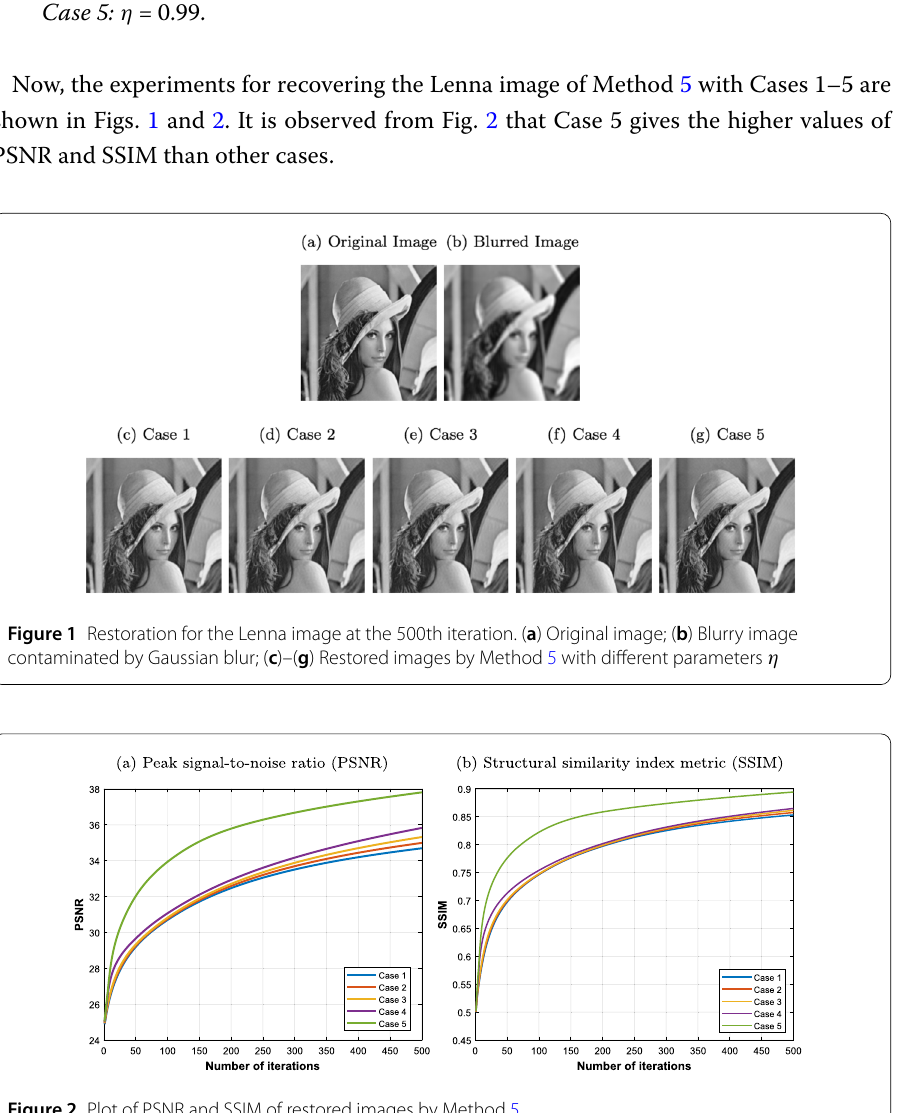
Figure 2 Plot of PSNR and SSIM of restored images by Method